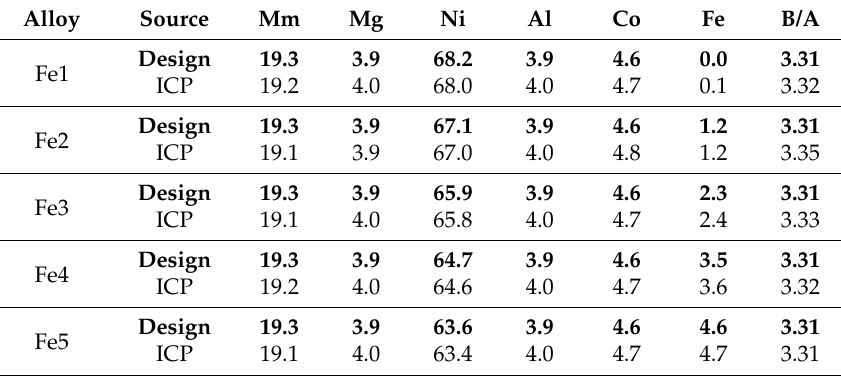
Table 1. Designed compositions (in bold ) and inductively coupled plasma (ICP) results in at%. Mm stands for misch metal (mixture of rare earth elements).